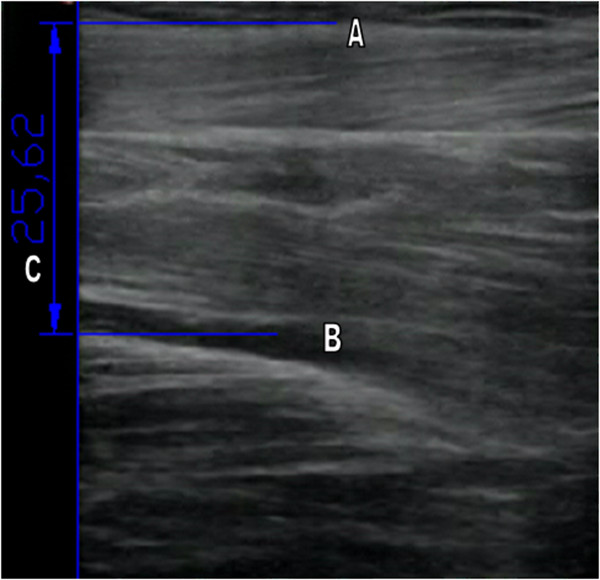
Measurement of the muscle thickness of TA muscle. A. Surface edge. B. Surface of the tibia. C. Muscle thickness.